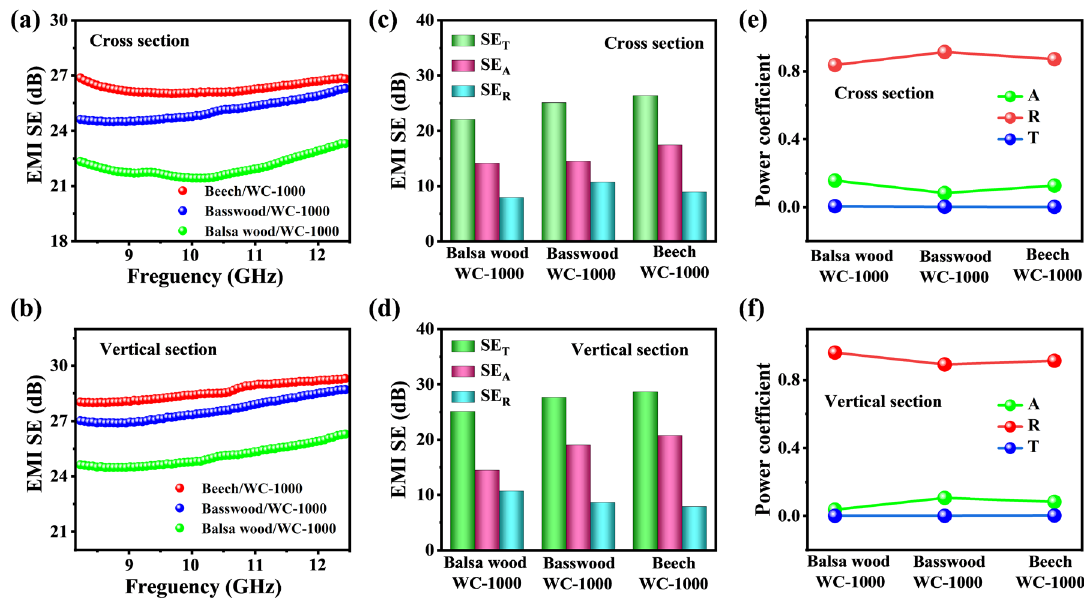
Figure 5. ( a , b ) EMI SE T ; ( c , d ) comparison of the average SE T , SE A and SE R values; and ( e , f ) the A, R and T values of WC-1000 (balsa wood, basswood and beech) under different sections.